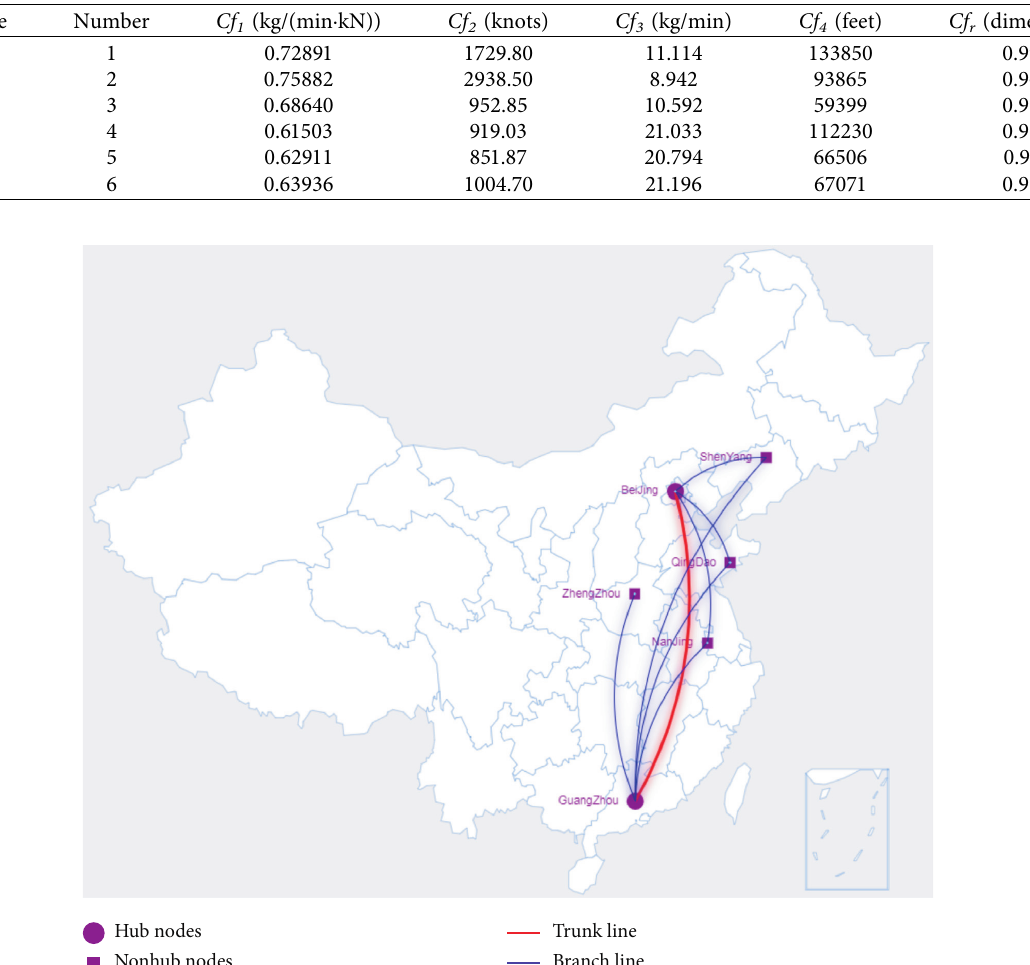
Table 4: Fuel consumption reference value for each type of aircraft.